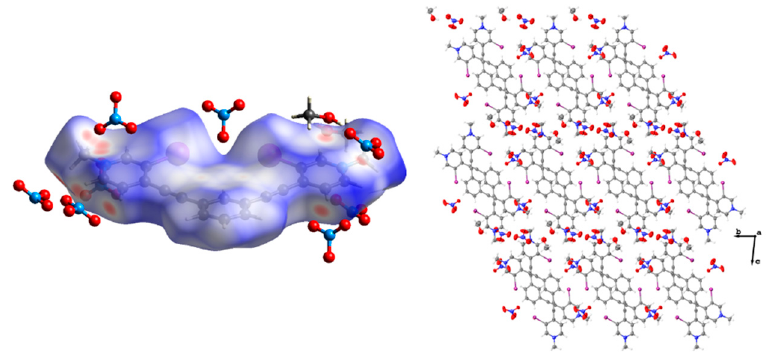
Figure 6. Hirshfeld surface map of 3 • MeOH highlighting the C-H hydrogen bonding contacts and arrangement of nitrate anions and methanol molecules around the receptor ( left ). Packing diagram of 3 • MeOH when viewed down the crystallographic a axis ( right ). Anion disorder omitted for clarity, and thermal ellipsoids are drawn at the 50% probability level. Table 2. Halogen bond parameters for reported structures.